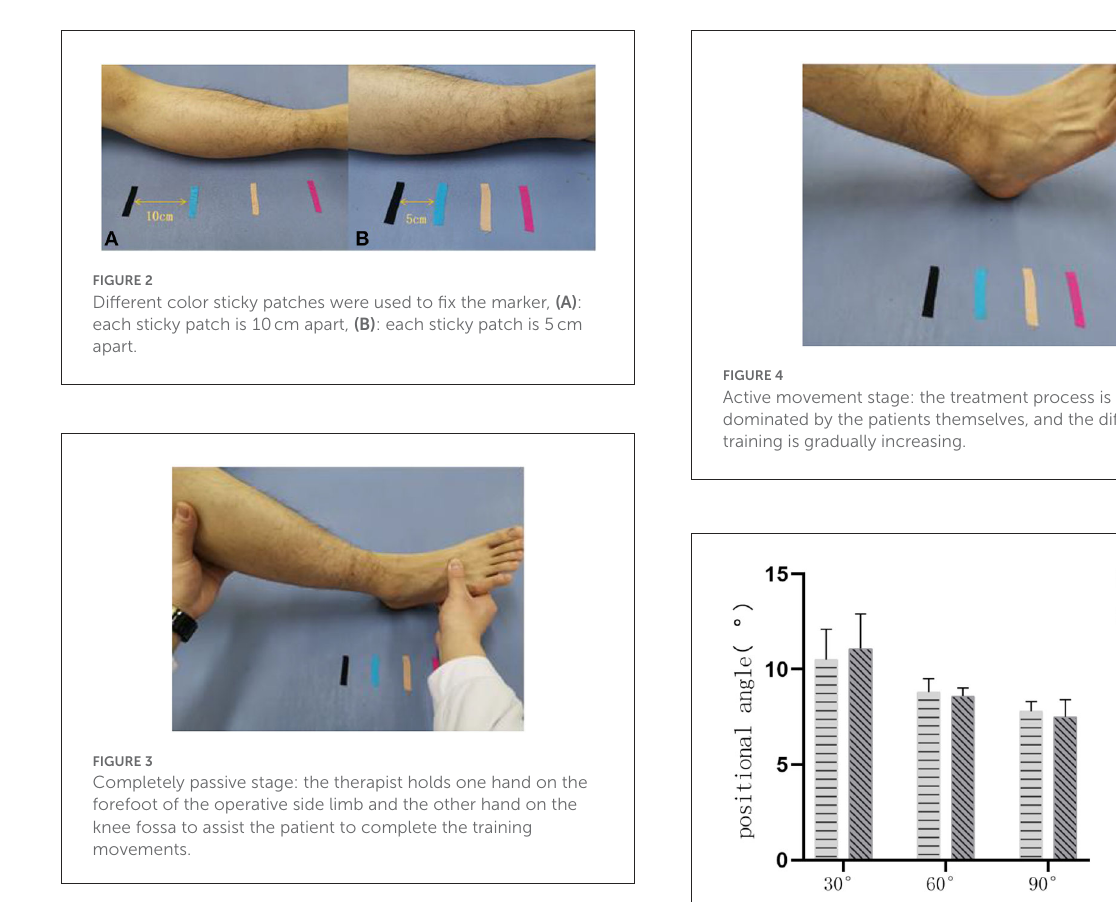
FIGURE5 Proprioception before treatment: Before treatment, there was no statistically significant difference in the positional angle between the CTE group and the NCTE group ( P > 0.05). CTE, cognitive therapeutic exercise; NCTE, no cognitive therapeutic